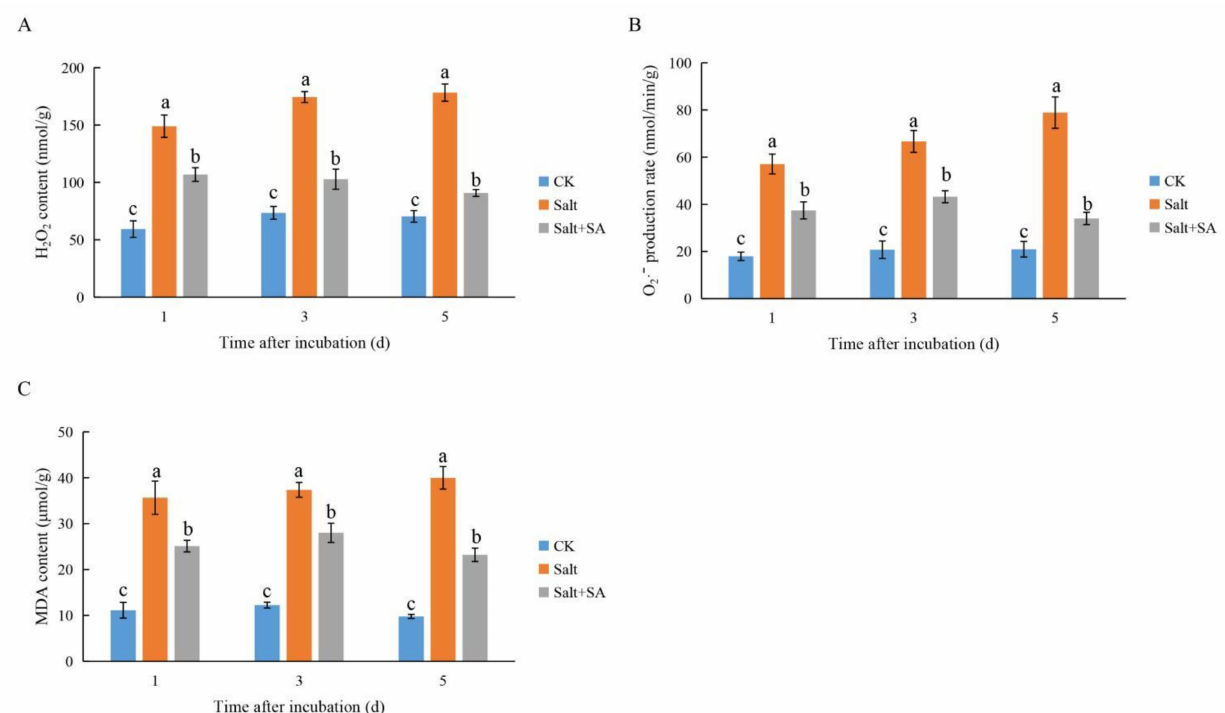
Figure 5. Effects of exogenous salicylic acid (SA) on the accumulation of H 2 O 2 , O 2 − , and malon- aldehyde (MDA) in rice seeds under salt stress. Seeds of Nipponbare were incubated in distilled water (CK), 150 mM NaCl (Salt), and 150 mM NaCl + 0.1 mM SA (Salt + SA) for 1, 3, and 5 days. The accumulation of H 2 O 2 ( A ), O 2 − ( B ), and MDA ( C ) in seeds subjected to the different treatments and incubation times are compared. Data are presented as means ± SE. Different lowercase letters indicate significant differences between treatments ( p < 0.05).